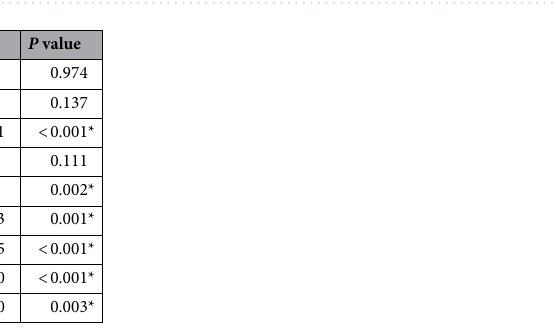
Figure 1. Representative cases of MacTel type 2 with severity 3. ( A , B ) A 58-year-old woman presented with a right-angled vessel (RAV, yellow arrows) on fundus photography (FP) and fluorescein angiography (FAG) of the right eye. ( C ) In the cross-section optical coherence tomography (OCT) B-scan (corresponding blue line in B ), there were hyporeflective retinal cavities, ellipsoid zone (EZ) disruption, and interdigitation zone (IDZ) disruption. ( D , E ) A 59-year-old man with RAV on FP and FAG of the right eye. ( F ) Hyporeflective retinal cavities, EZ disruption, and IDZ disruption were noted on cross-section OCT B-scan (corresponding blue line in E ). ( G , H ) A 59-year-old female without RAV on FP and FAG of the left eye. ( I ) In the cross-section OCT B-scan (corresponding blue line in H ), there were only inner hyporeflective retinal cavities.